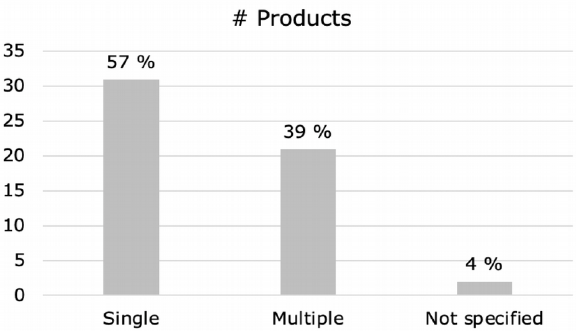
Figure 7. Statistics on supply chain structure: # Products